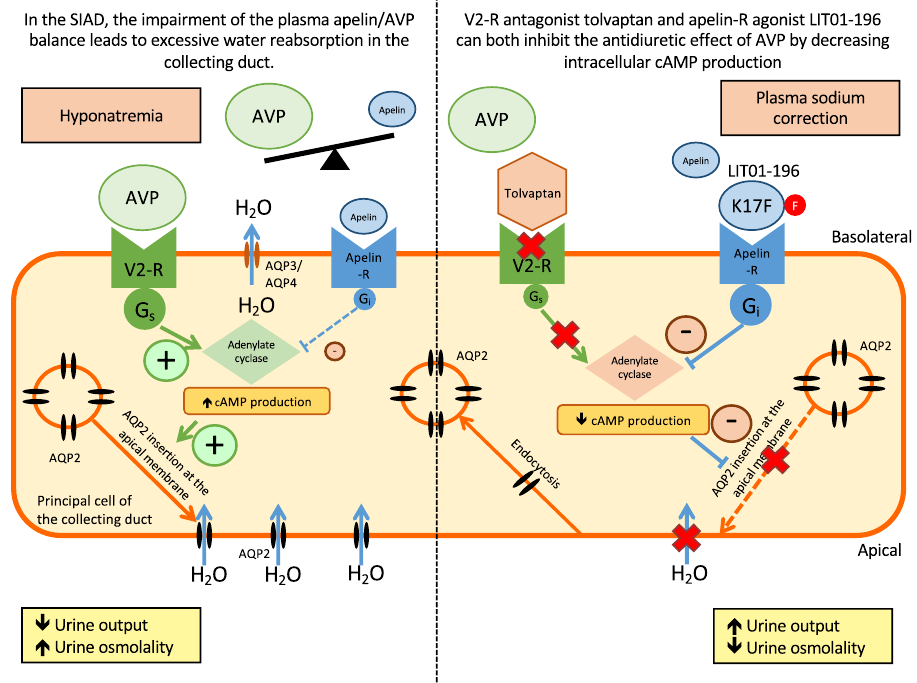
Fig. 7 Proposed model of the effects of LIT01-196 on the principal cell of the collecting duct in SIAD. This fi gure was modi fi ed from Flahault et al. 31 , available at